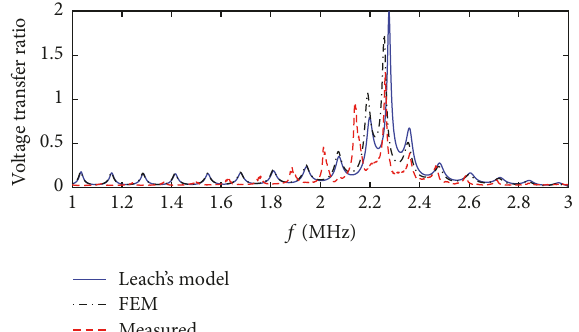
Figure 14: Output-to-input voltage transfer ratio of the channel through a planar metal barrier.